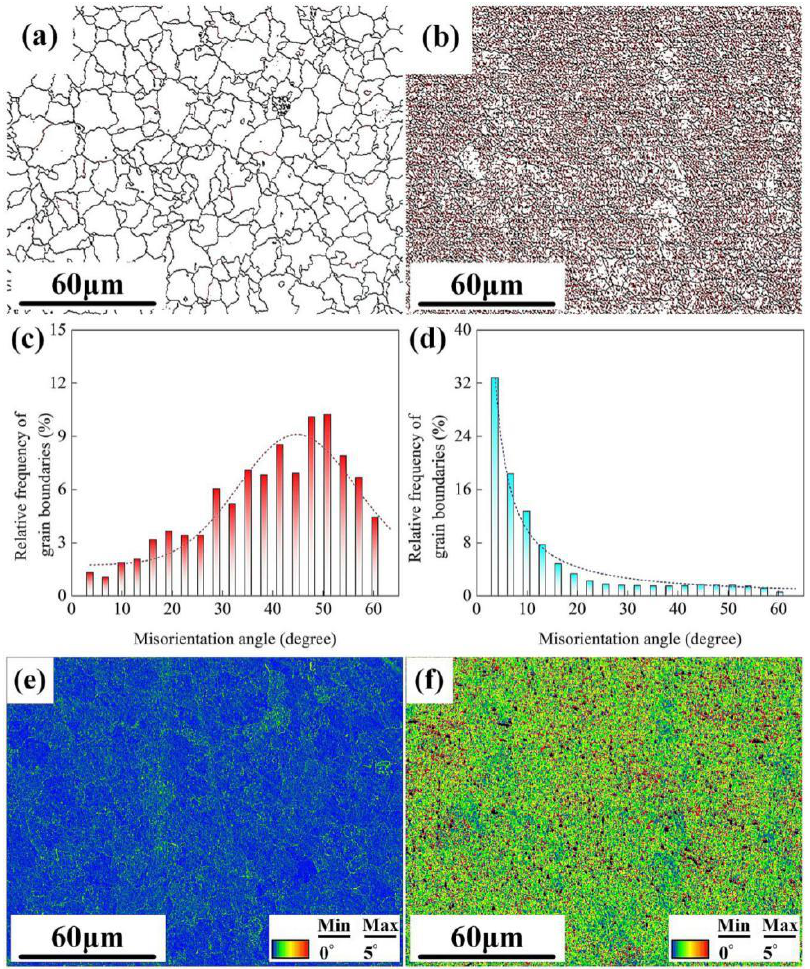
Figure 3. Microstructure of the spheroidized experimental steel characterized by EBSD: the grain boundaries maps ( a ) without and ( b ) with CR; the distribution of misorientation angle ( c ) without and ( d ) with CR; the Kernel Averaged Misorientation (KAM) maps ( e ) without and ( f ) with CR. (EBSD: electron backscatter di ff